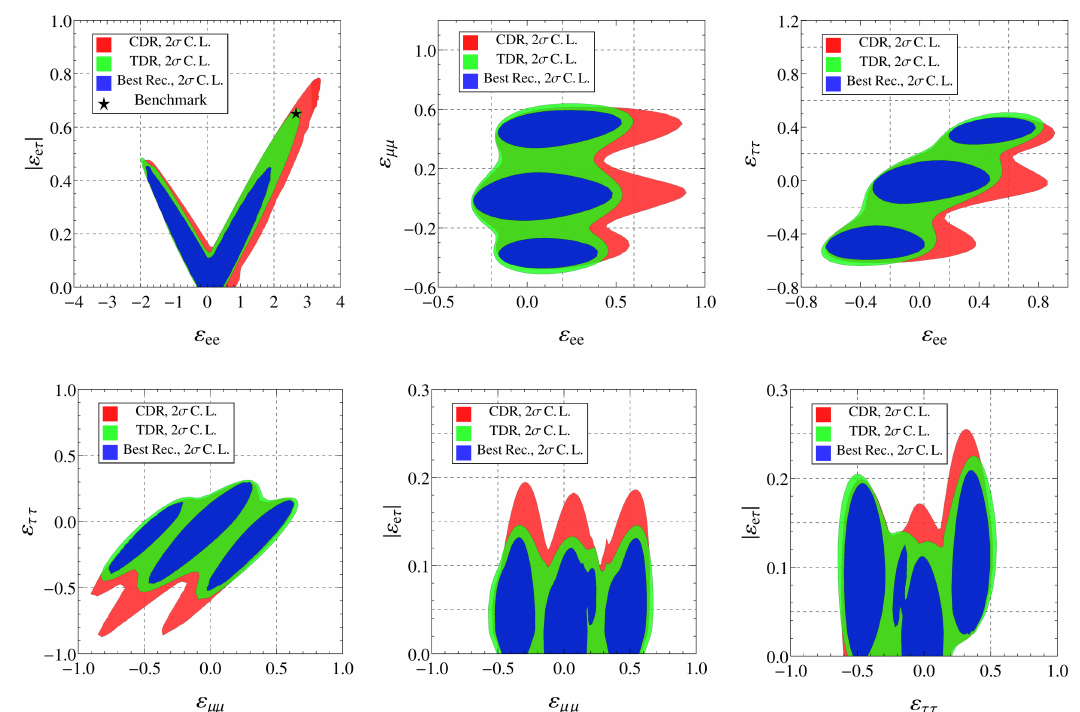
Figure 7 . 2 σ C.L. (2 d.o.f.) sensitivity regions spanned by the different sets of NSI parameters for three different cases CDR, TDR, and Best Reconstruction respectively. We have assumed δ CP (true) = − 90 ◦ and normal ordering is assumed in both true and test hypotheses of the analysis. The benchmark point marked in the upper left panel will be used later in section